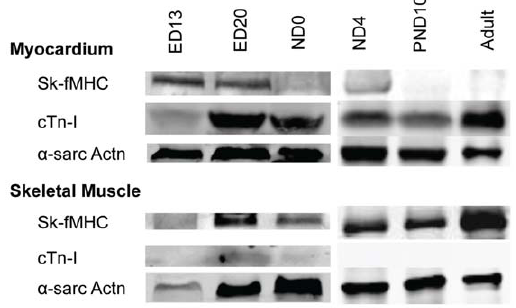
Figure 3. Western blot analysis of developing myocardium and skeletal muscle. Lane 1 : ED13; Lane 2 : ED20; Lane 3 : ND0; Lane 4 : ND4; Lane 5 : PND10; Lane 6 : Adult (8 week-old). Top panel : Left ventricular myocardium, Bottom panel : hind limbs at ED13, ED20, ND0, and ND4, and gastrocnemius muscle in PND10 and adult. At ED13 and ED20, left ventricular myocardium expressed sk-fMHC and